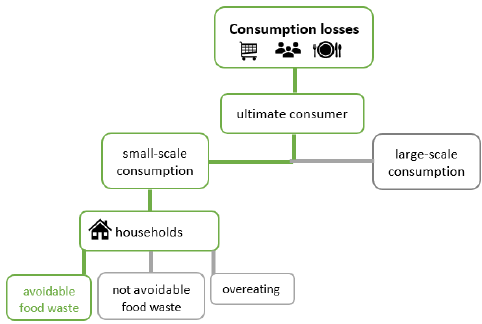
Figure 3. Consumption losses.